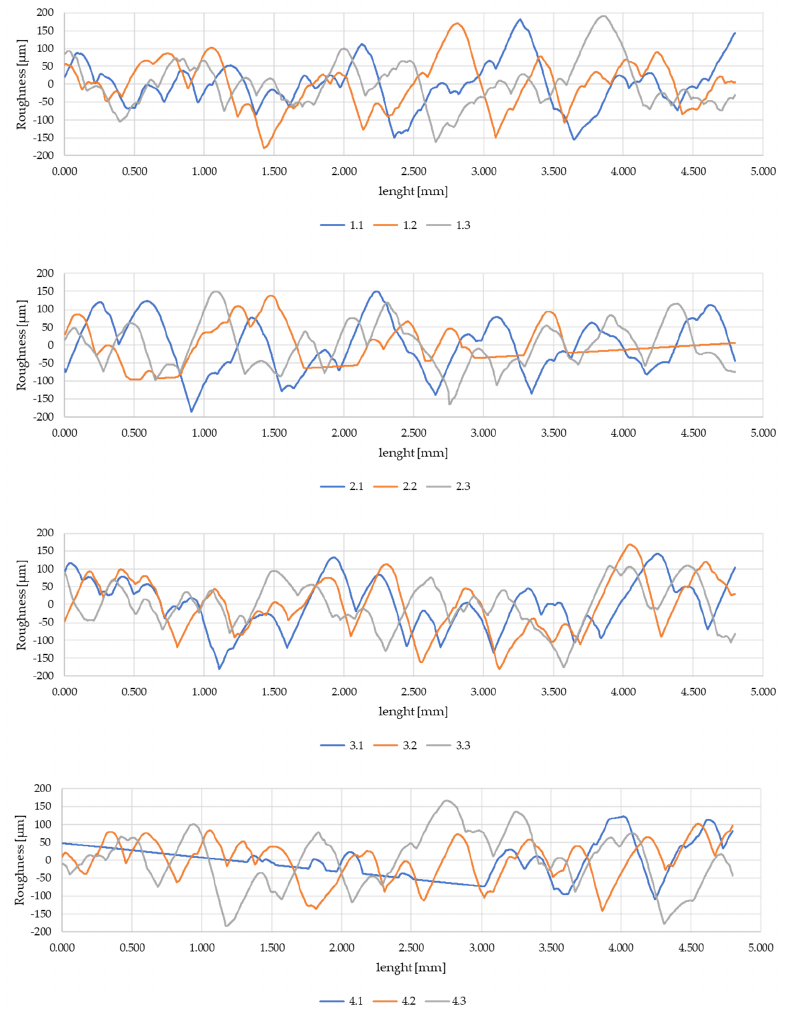
Figure A1. Surface roughness profiles from each surface. The measurements have been replicated three times. The first number (from 1 to 4) indicates the index of the surface; the second number (from 1 to 3) specifies the measure replica.